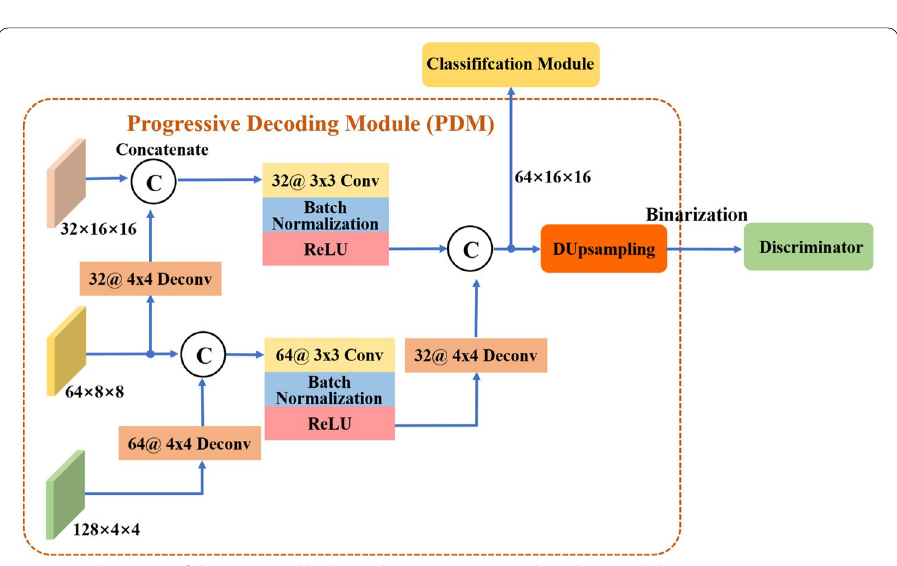
Fig. 5 Architecture of the proposed high-resolution progressive decoding module